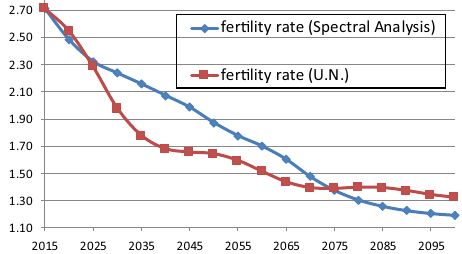
Figure 14. Forecasting the fertility rate with spectral analysis versus U.N. model (medium